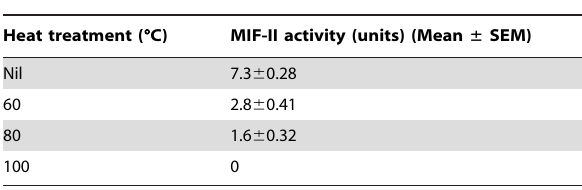
Table 2. Effect of heat treatment on motility inhibiting activity of purified